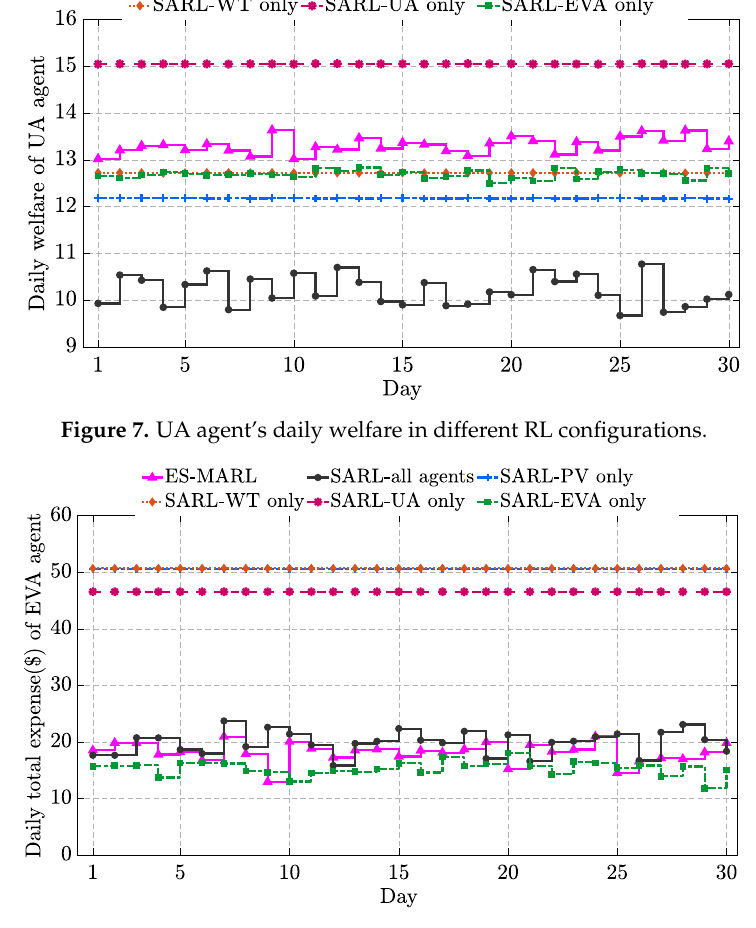
Figure 8. EVA agent’s daily expense in different RL